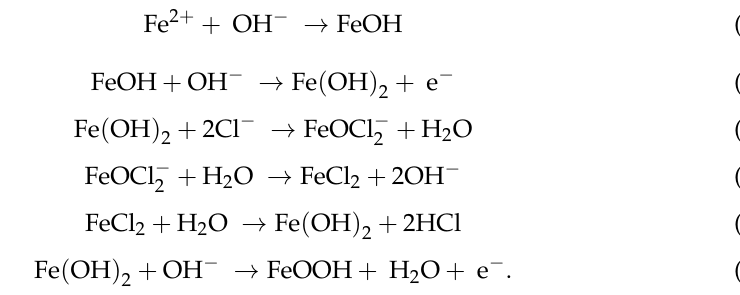
chloride contaminated O-SSA0, O-SSA10, O-SSA20, O-SSA30, O-SSA40, and